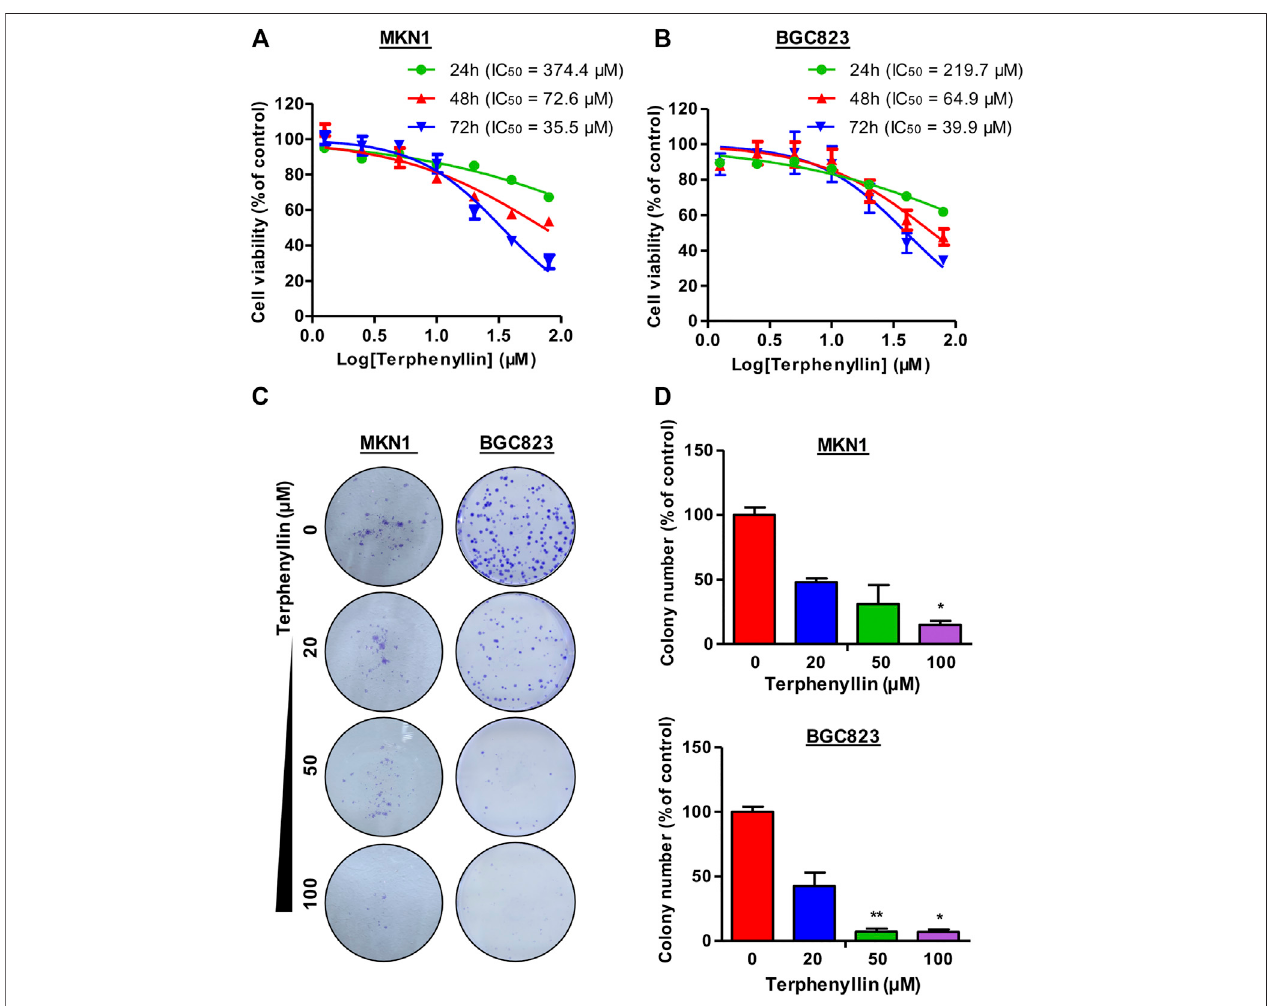
FIGURE2| Terphenyllininhibitsgastric cancercellgrowth invitro . (A,B) 24,48,72 hforthecell viabilityassaytodeterminethe50%inhibitoryconcentration(IC50) values,followedbyCCK8assays.CCK8experimentalsetupwasrepeatedthreetimesinparallel. (C,D) 24 hforthecolonyformationassay.Colonyformationsetupwas repeated two times in parallel. Results are presented as mean ± SD. ( p p < 0.05; pp p < 0.01, ppp p <